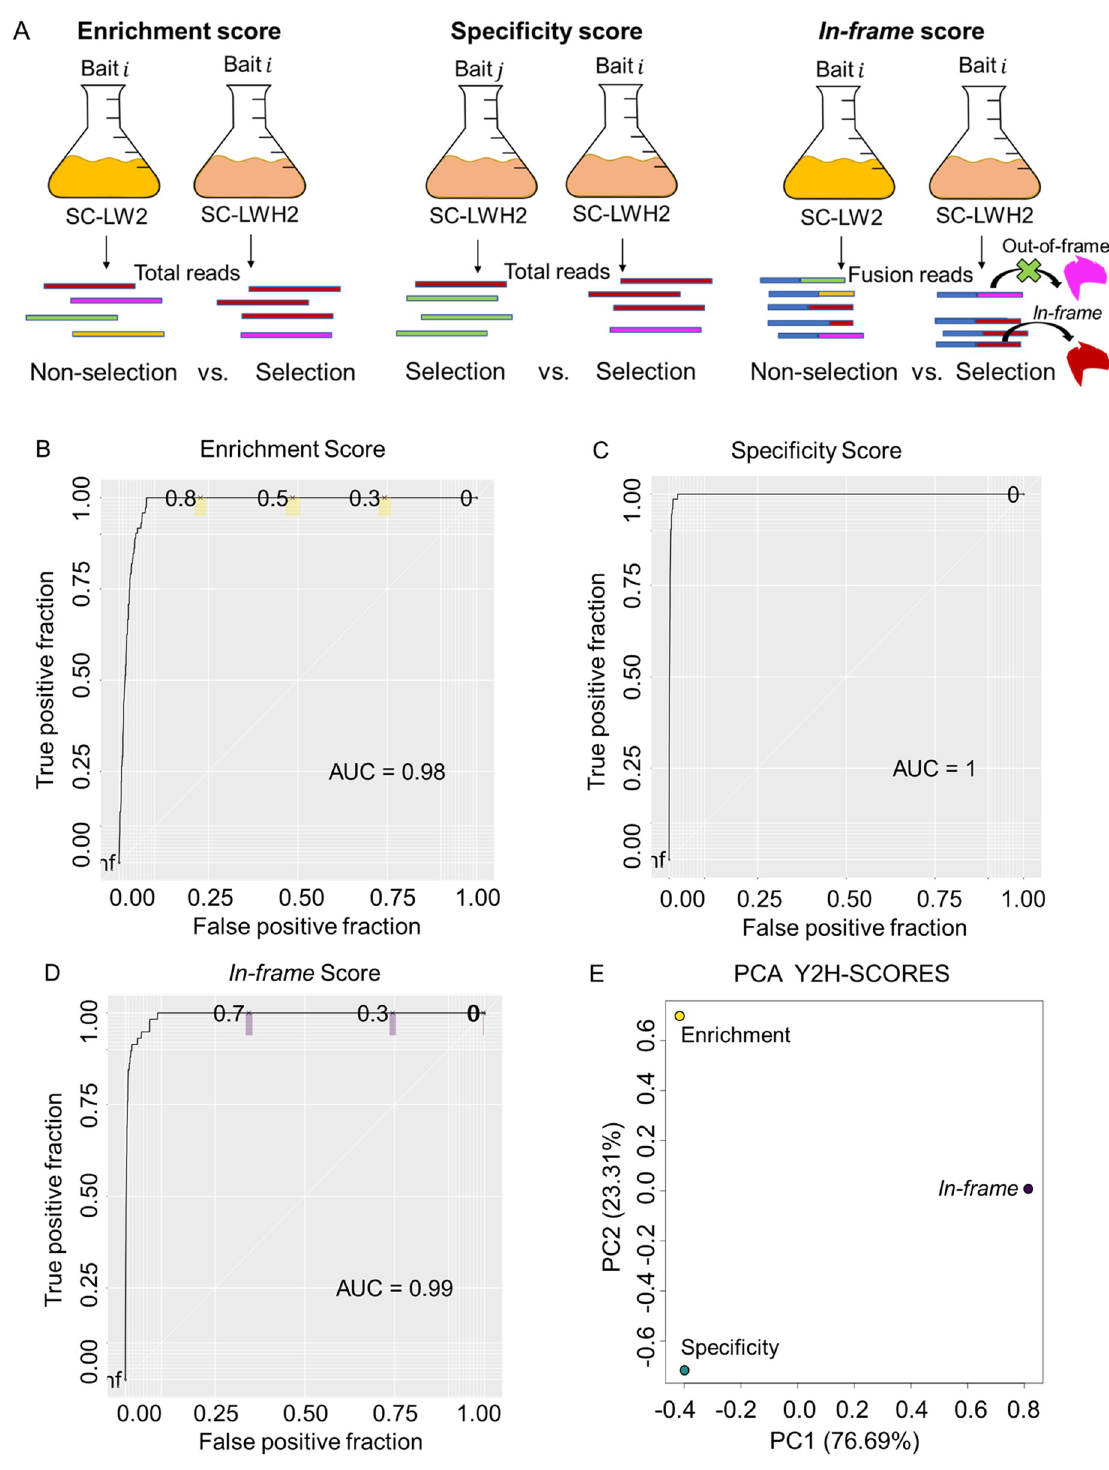
Fig 3. Principle of Y2H-SCORES and performance in an ideal scenario. A) Y2H-SCORES is comprised of the enrichment score, which detects changes in prey proportions in selected and non-selected conditions; the specificity score, which measures differences in the prey enrichments with different baits under selection; and the in-frame score, which identifies the enrichment of prey reading frames under selection, assigning higher values to in-frame preys. B) to D) ROC curves of the enrichment, specificity, and in-frame scores in an ideal scenario. Colored sections represent 95% confidence intervals for the score values 0.7, 0.5, and 0.3. E) PCA of the Y2H-SCORES calculated under the ideal scenario.